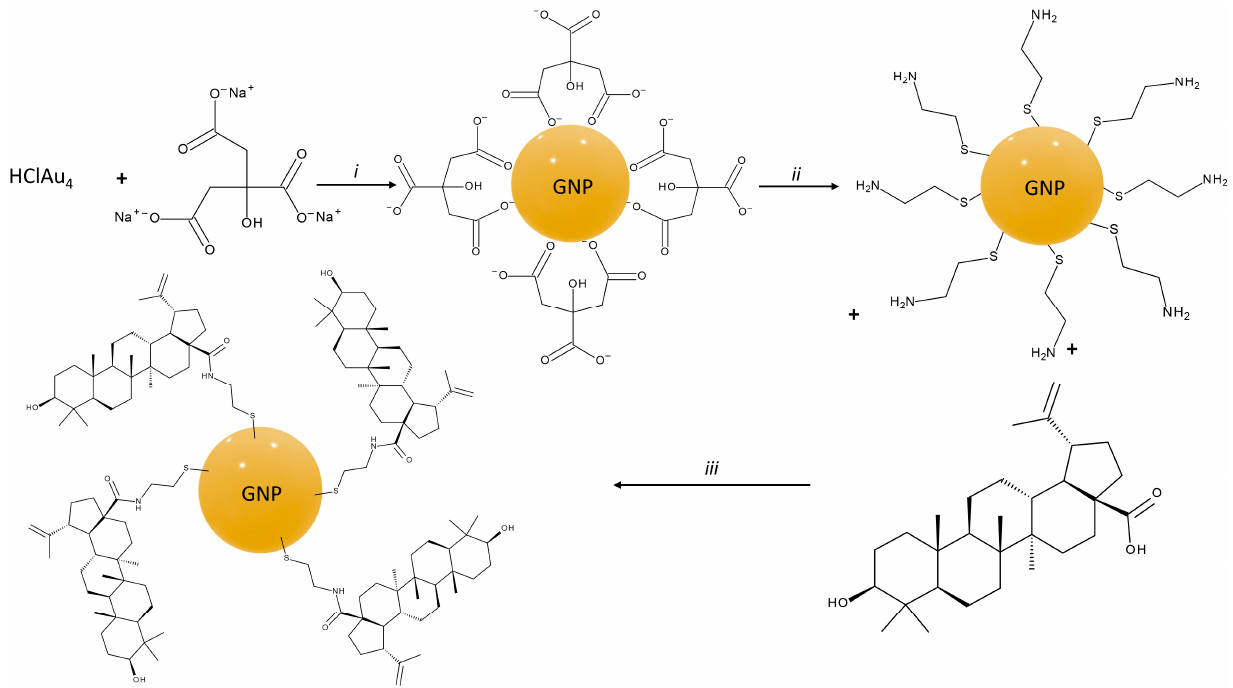
Figure 1. Synthesis route for citrate-capped GNP and BA-GNP; conditions: ( i ) H 2 O, boil, ( ii ) Stirred at r.t. for 10 min; ( iii ) EDC, ultrasonication, 1 h, after which stirred at r.t. for 24 h.